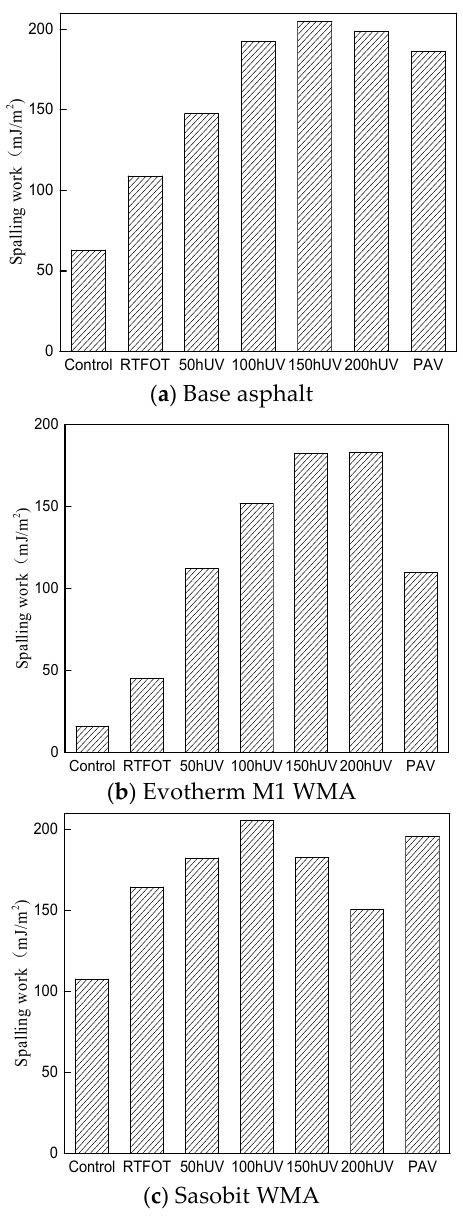
Figure 7. Influence of aging on spalling work of aged asphalt.